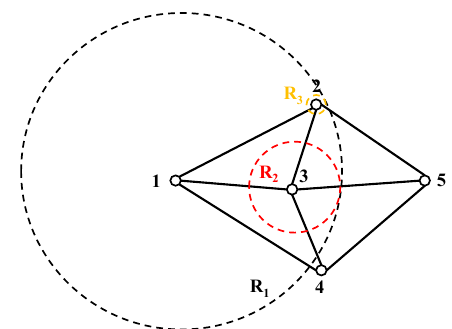
Fig. 8 The ripple spreading motion at t = 2